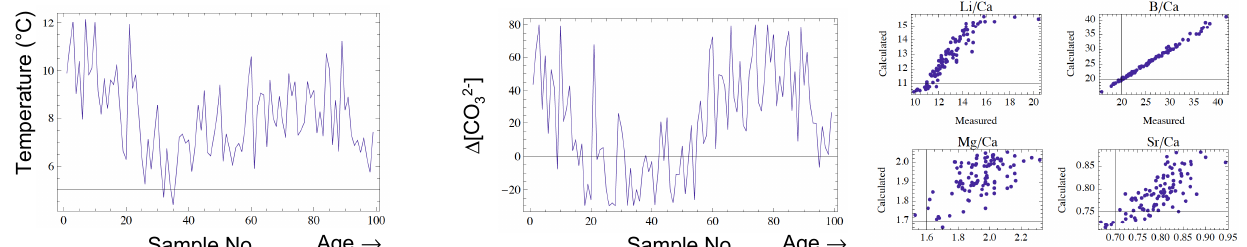
Fig. 4. Examples of O. umbonatus X/Ca multiple regression solutions determined from global minimization. For each solution, the temper- ature and bottom water 1 [CO 2 − ] regression coefficients are shown, together with the downcore temperature and bottom water 1 [CO 2 − 3 reconstructions and cross plots of the calculated (estimated from global minimization) and measured (actual)